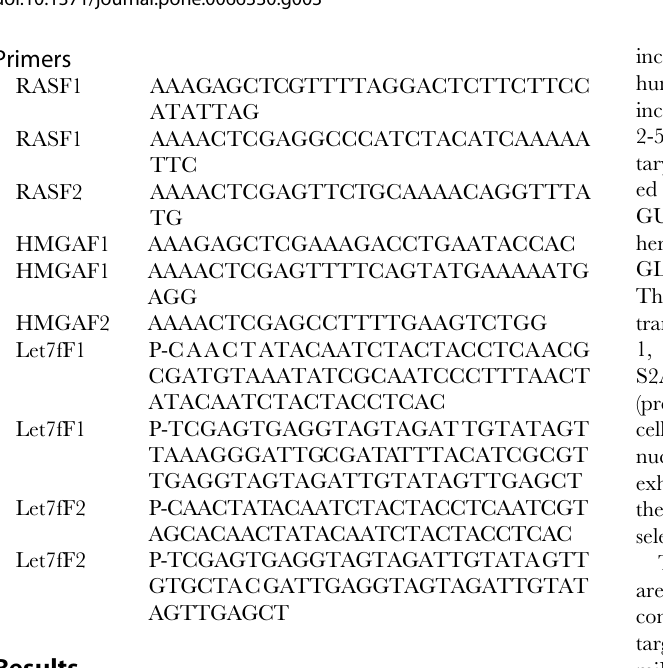
Figure 3. GSK-3 b silencing increases mature let-7 levels. Forty-eight hours after transfecting BG-1 cells with 100 nM Ctrl siRNA or GSK-3 b siRNA, total RNA was collected and mature let-7 miRNAs, as well as two control microRNAs (mir-24, and mir-25) were quantified by RT-qPCR and normalized to U6 snRNA. Data are the means and S.D. from at least three independent experiments.